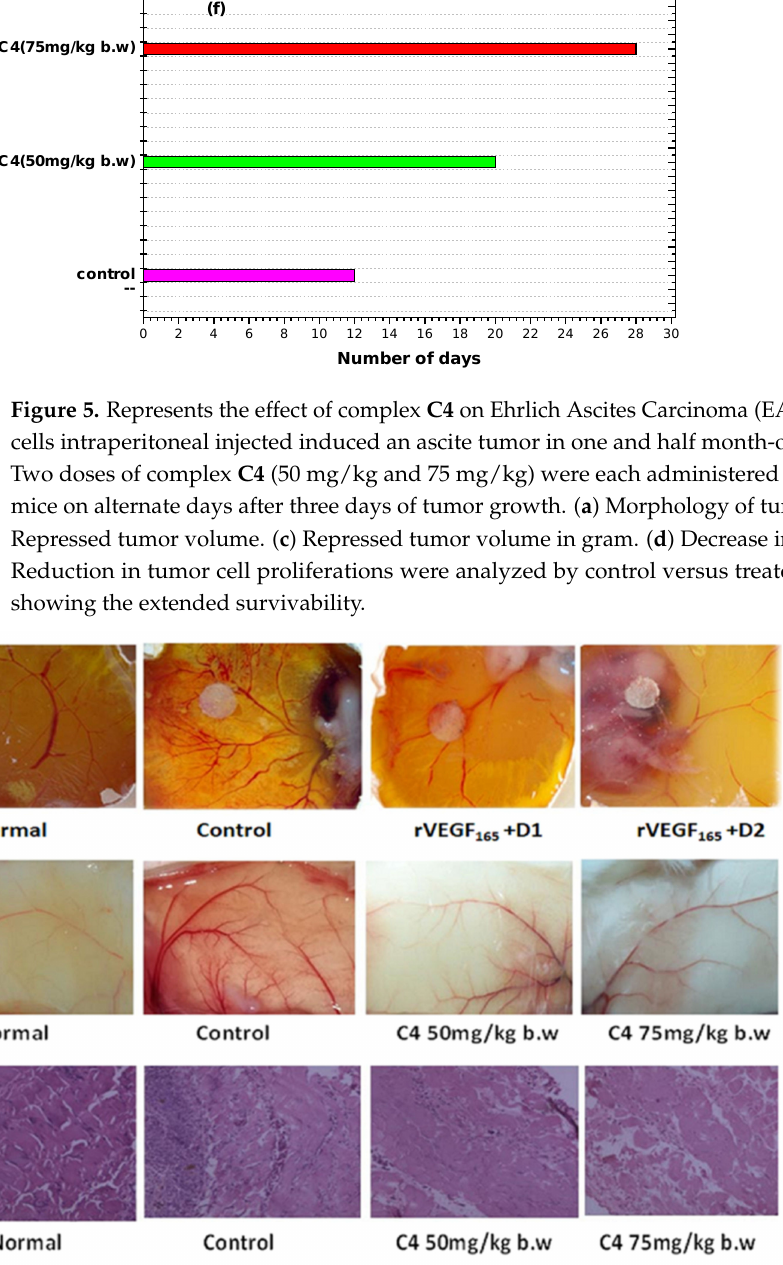
Figure 6. Complex C4 antagonizes the microvascular formation in non-tumor antigenic models. The effect of complex C4 on neovascularization was studied by stimulating angiogenesis with rVEGF 165 and treating with the complex C4 the non-tumor models. ( A ) Ex vivo and ( B ) In vivo CAM Photographs represent the inhibition of neovasculature formation, ( C ) Antiagiogenic effect of complex C4 was evident from haematoxylin and eosin staining of peritoneum section showing the decreased in vascular